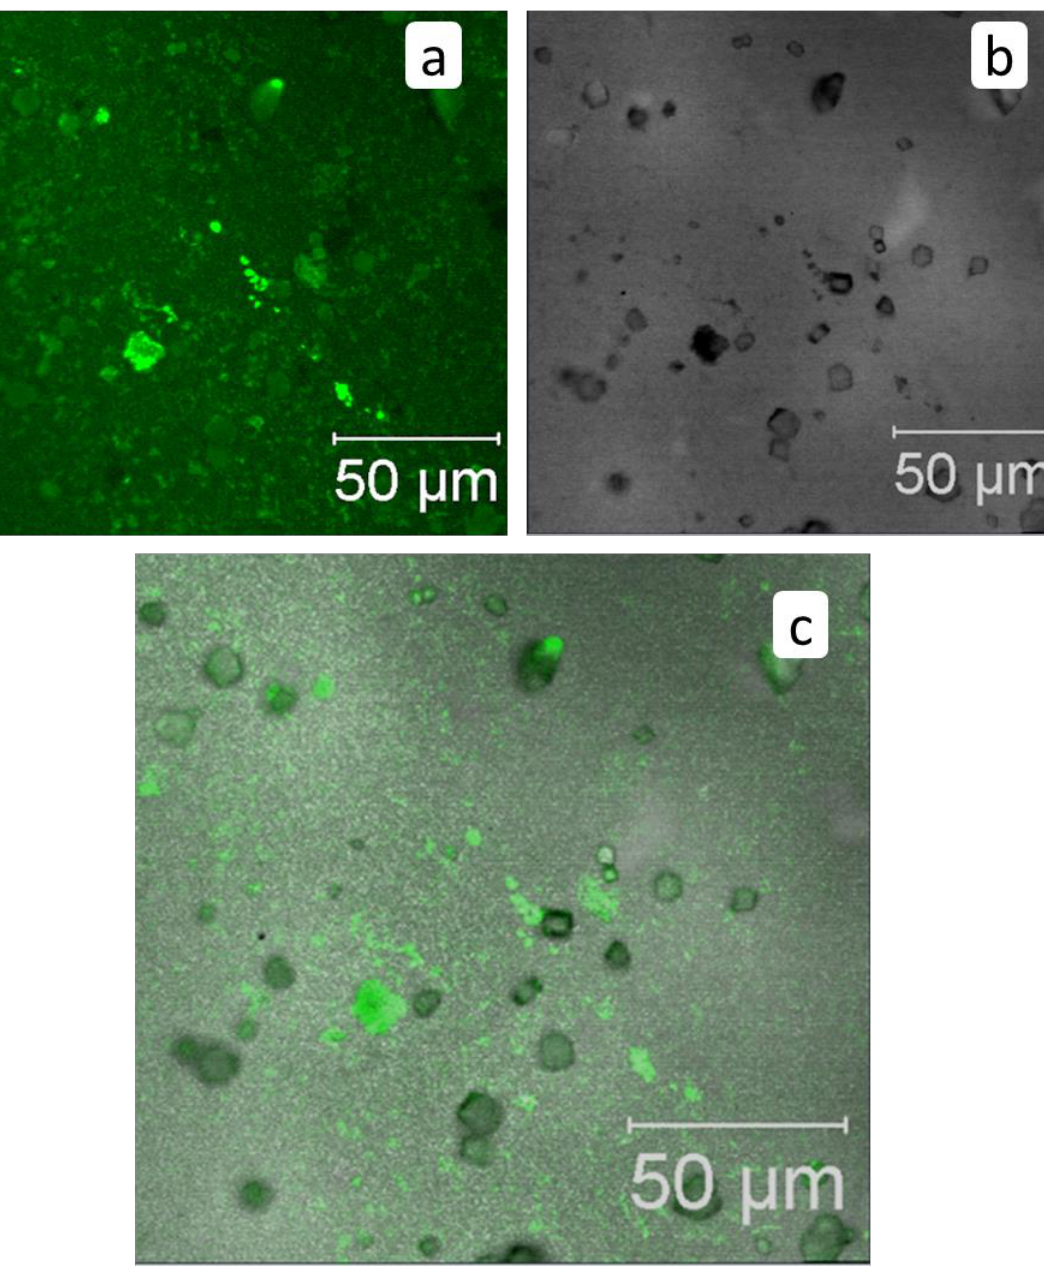
Figure 9. Fluorescent images of membrane surface after RO treatment in presence of HEDP-F: a — HEDP-F fluorescence - green pseudo-color, b — transmitted light image (grey color), c —imposition of a and b channels. a , b